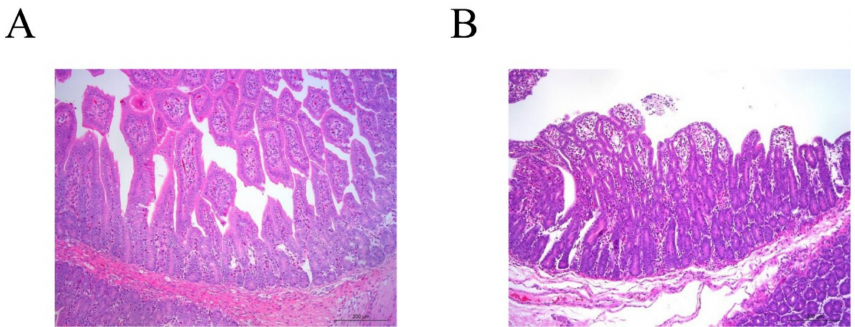
Figure 1. ( A ) Electron micrograph of purified isolate negatively stained with 2% phosphotungstic acid. ( B ) Ultra-thin sections of infected VERO-E6 cells displaying typical viral particles, organized as paracrystalline structures within cytosol. Scale bar, 200 nm.